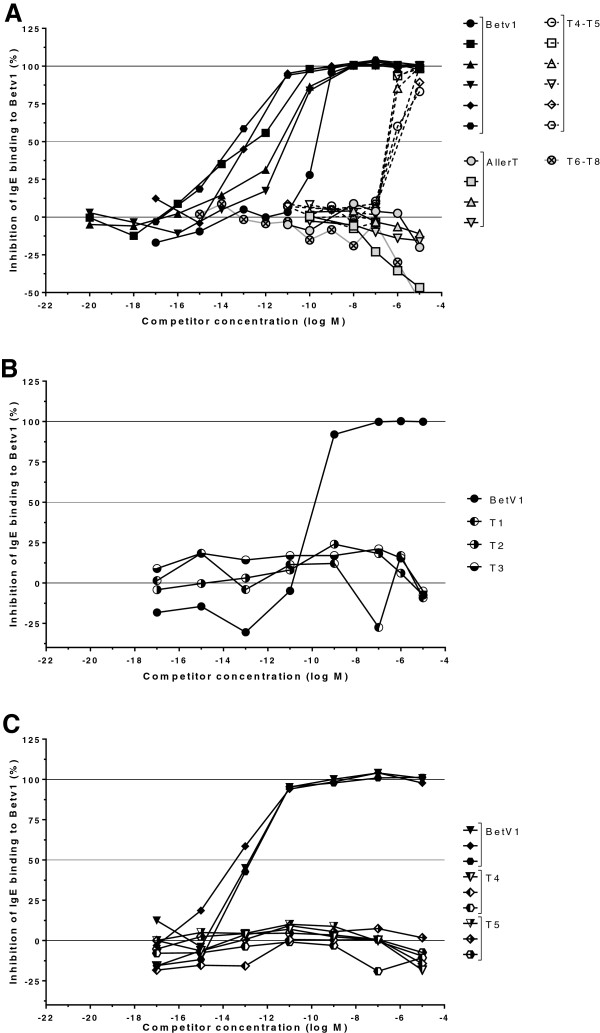
Human IgE competition assays. rBet v 1-specific IgE were measured by ELISA in sera from individual birch pollen allergic patients pre-incubated with increasing concentrations of either rBet v 1 or COPs as indicated on the X axis. Panel A: Sera from six allergic patients (indicated by various symbol shapes) were pre-incubated with either rBet v 1 (black symbols), AllerT (grey symbols), T4-T5 (open symbols) and T6-T8 (crossed circles). Panel B: Individual COPs T1, T2 and T3 were tested separately with serum from a representative patient as indicated in the Figure (control rBet v 1, black circles). Panel C: Sera from three allergic individuals was reacted with either T4 or T5 (black & white symbols) alone or control rBet v 1 (black symbols). Inhibition of binding is expressed as the inverse of the percentage of residual IgE binding to Bet v 1.